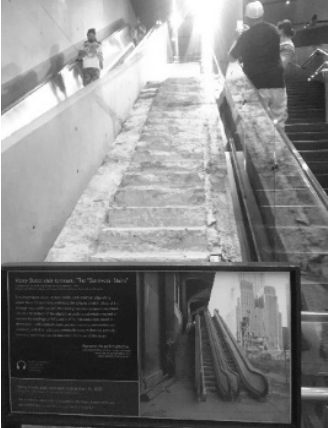
Figure 6. An exhibit with a reference map to the bombing site at the 9/11 memorial site.